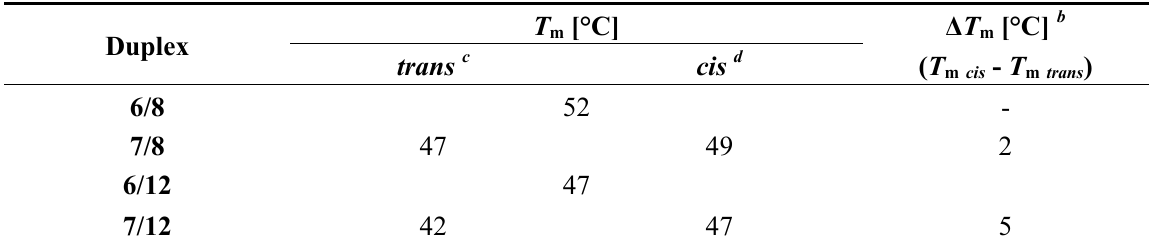
Table 2. UV-melting points of 12-bp duplexes. a